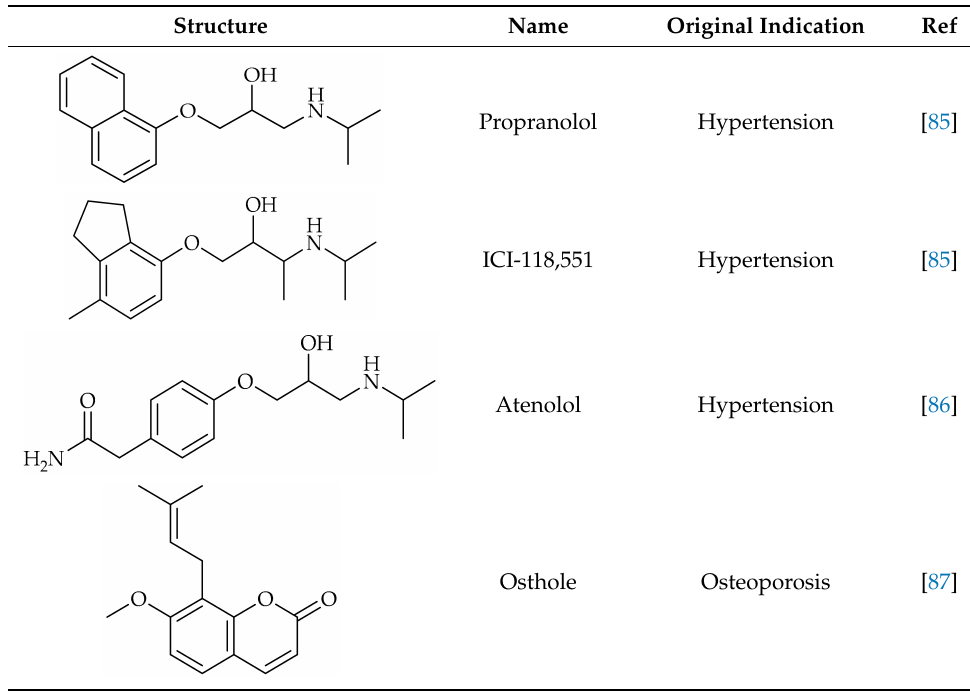
Table 1. Structures of repurposed drugs studied for the treatment of